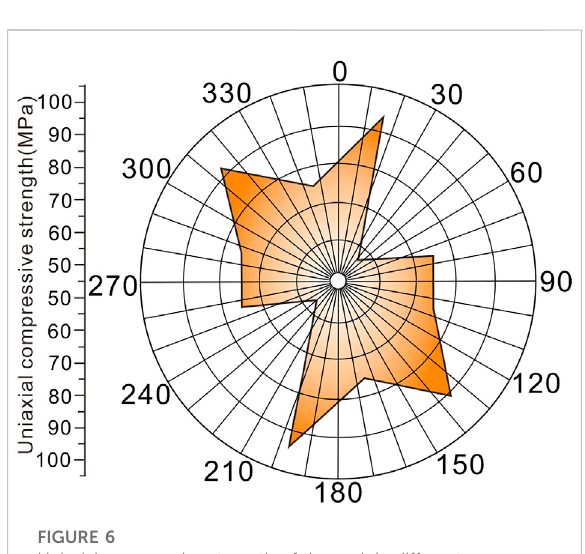
FIGURE 6 Uniaxial compressive strength of the rock in different directions for low-permeability sandstone in the Longdong area (P2, P8, and P10) (according to Zeng et al.,